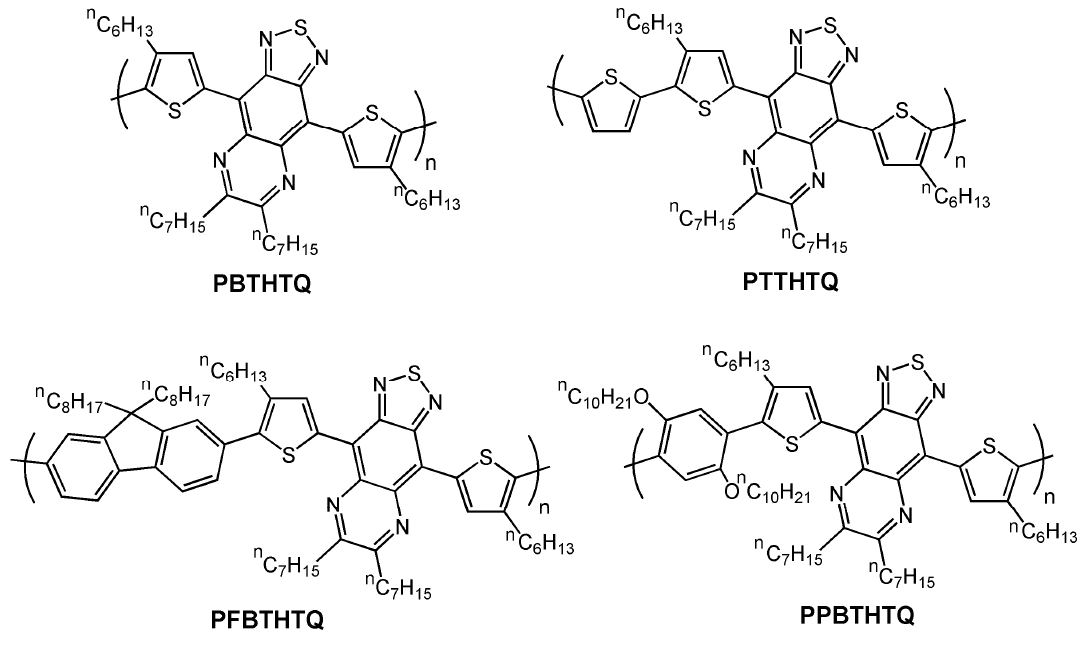
Figure 14. Chemical structures of the semiconducting copolymers PBTHTQ , PTTHTQ , PFBTHTQ , and PPBTHTQ .